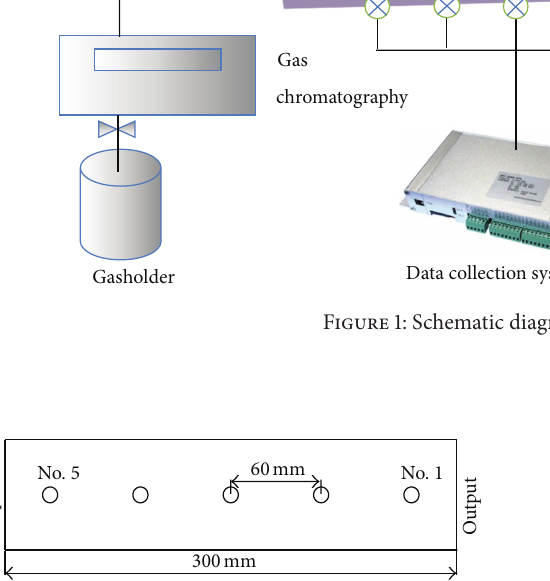
Figure 2: Map of measuring pressure and sampling